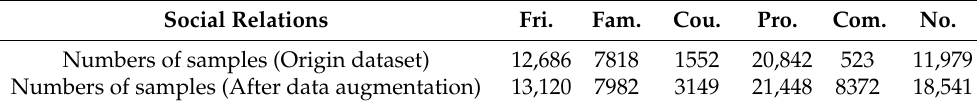
Table 6. The sample distribution of the PISC dataset. Row 1 denotes the sample numbers of the original dataset, while row 2 shows the sample numbers after the data augmentation strategy is employed. Social Relations Fri. Fam. Cou. Pro. Com. No. Numbers of samples (Origin dataset) 12,686